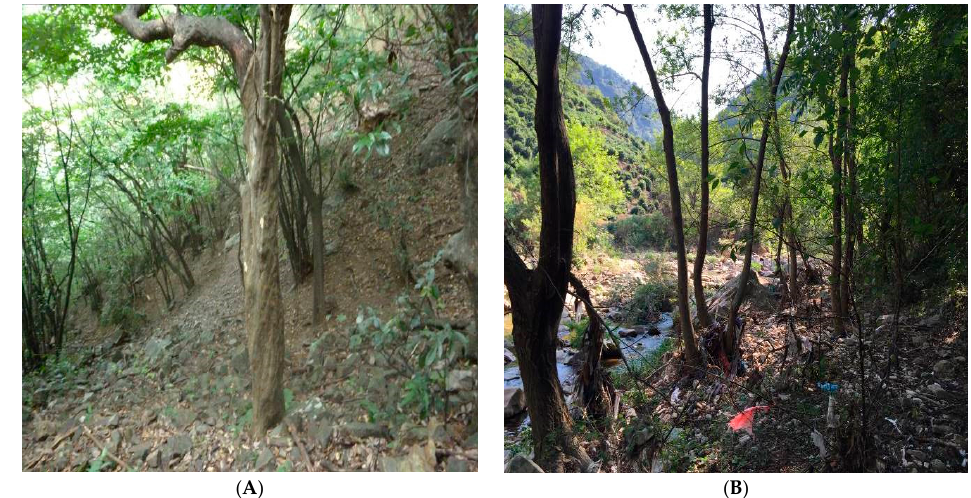
Figure 2. Habitats of P. subaequalis in eastern China: ( A ) hillside habitat in Jingde, Anhui; and ( B ) valley habitat in Tongcheng, Anhui.